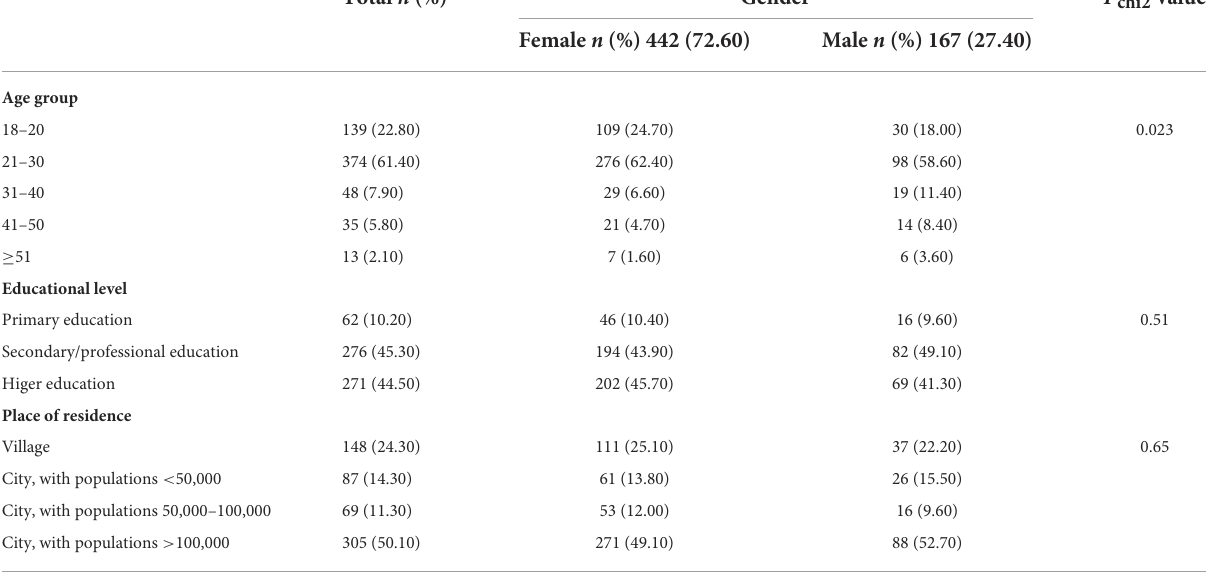
TABLE 1 Characteristics of the study group by